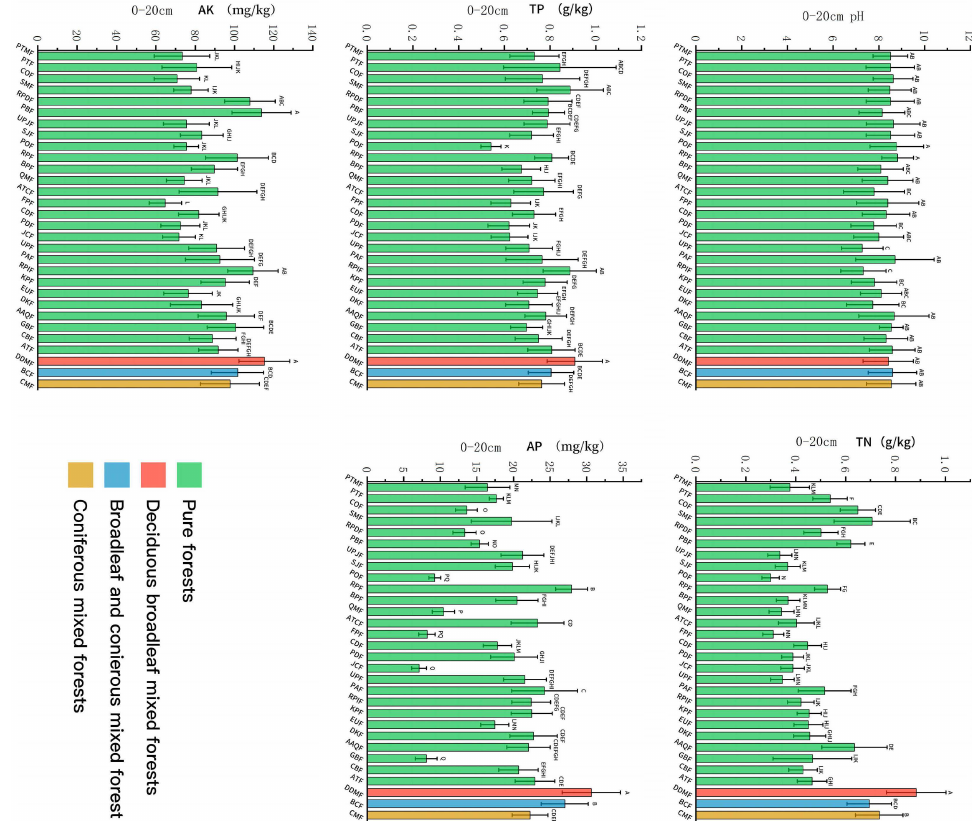
Figure 5. Multiple comparative analyses of soil chemistry in different urban forest communities. pH: hydrogen ion concentration; TN: total nitrogen; TP: total phosphorus; AP: available phosphorous; AK: available potassium. Note: Different lowercase letters indicate significant differences in the values of soil physical properties between different community types ( p < 0.05). Abbreviations of community names refer to Table